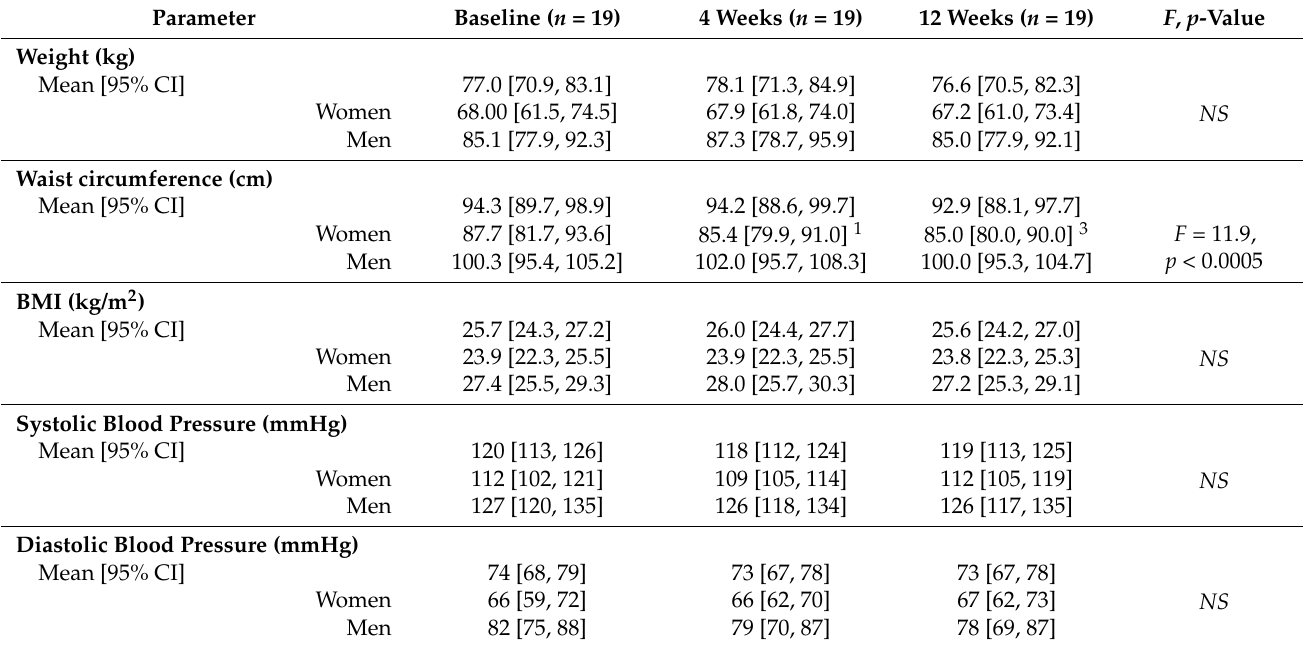
Table 2. Clinical parameters of healthy volunteers for each experimental time. Mean [95% CI], n = 19 (Women, n = 9 and men, n = 10).